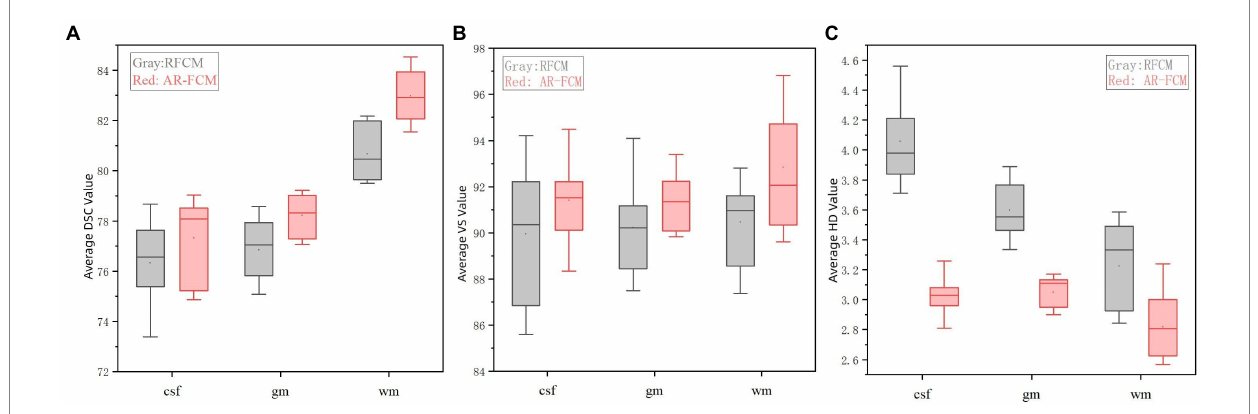
FIGURE 6 Indicator data visualization results. (A) Average DSC values of AR-FCM and RFCM, (B) average VS values of AR-FCM and RFCM, and (C) average HD values of AR-FCM and